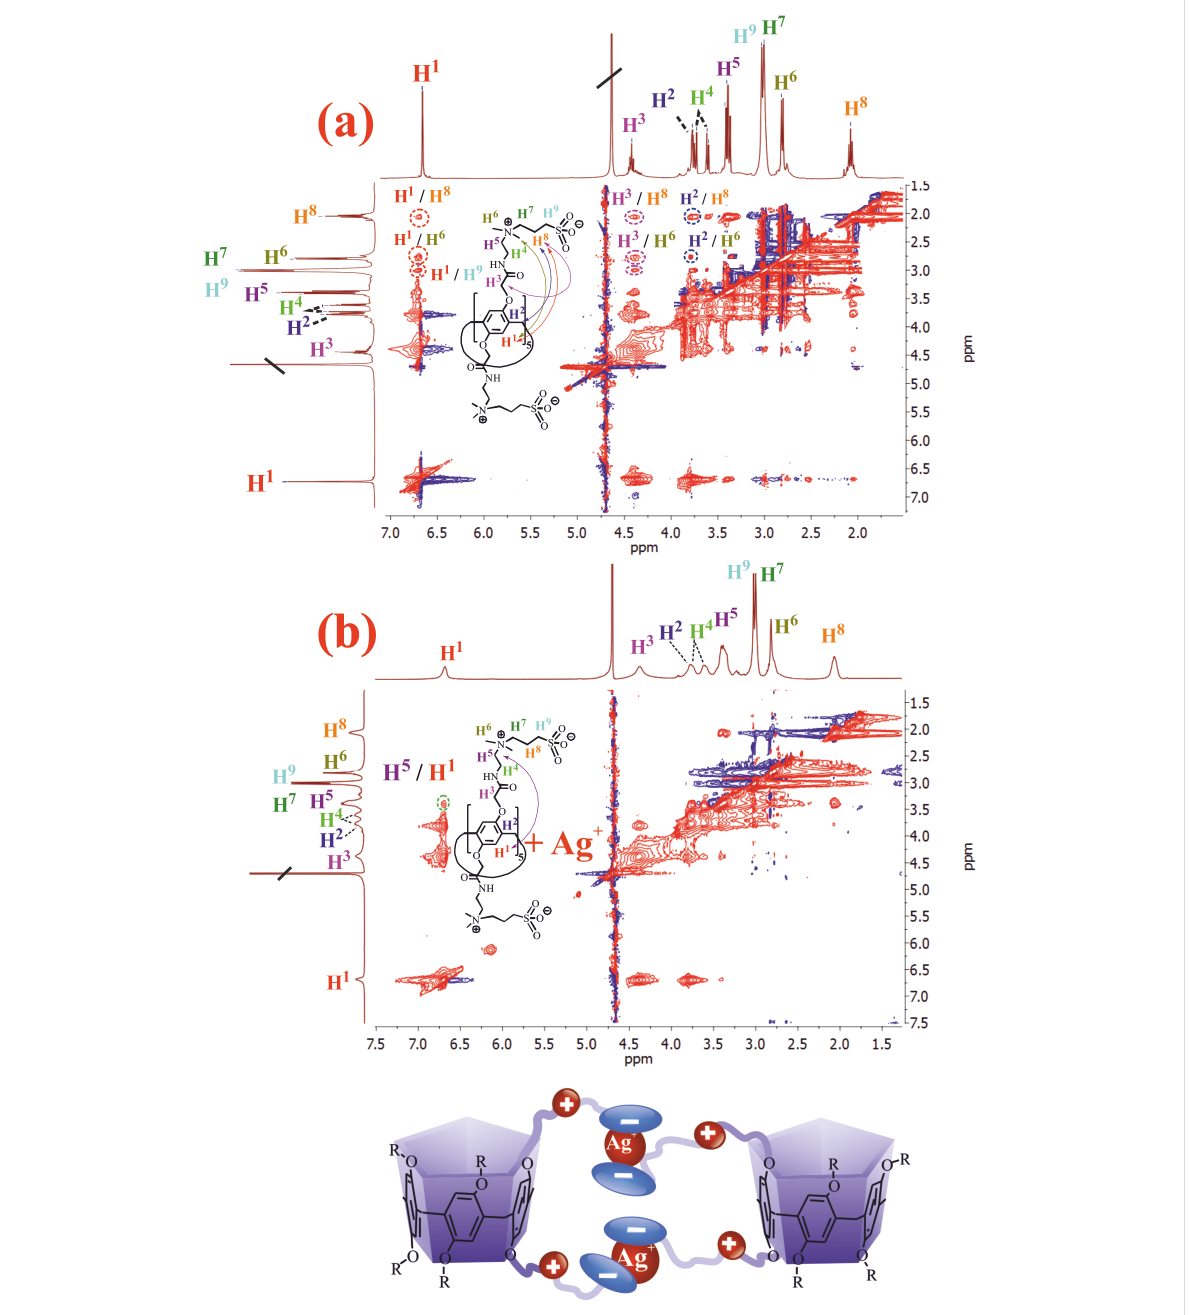
Figure 3: 2D 1 Н , 1 Н -NOESY NMR spectra: (a) macrocycle 3 (10 − 3 M); (b) associate 3 /Ag + at a ratio of 1:10 in D 2 O at 298 K and the estimated struc- ture of the complex.